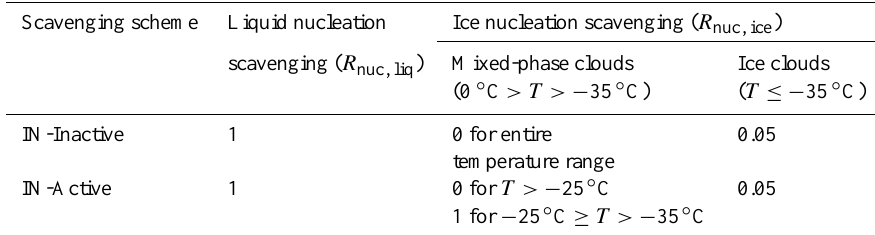
Table 2. Nucleation scavenging schemes used in EMAC. Scavenging